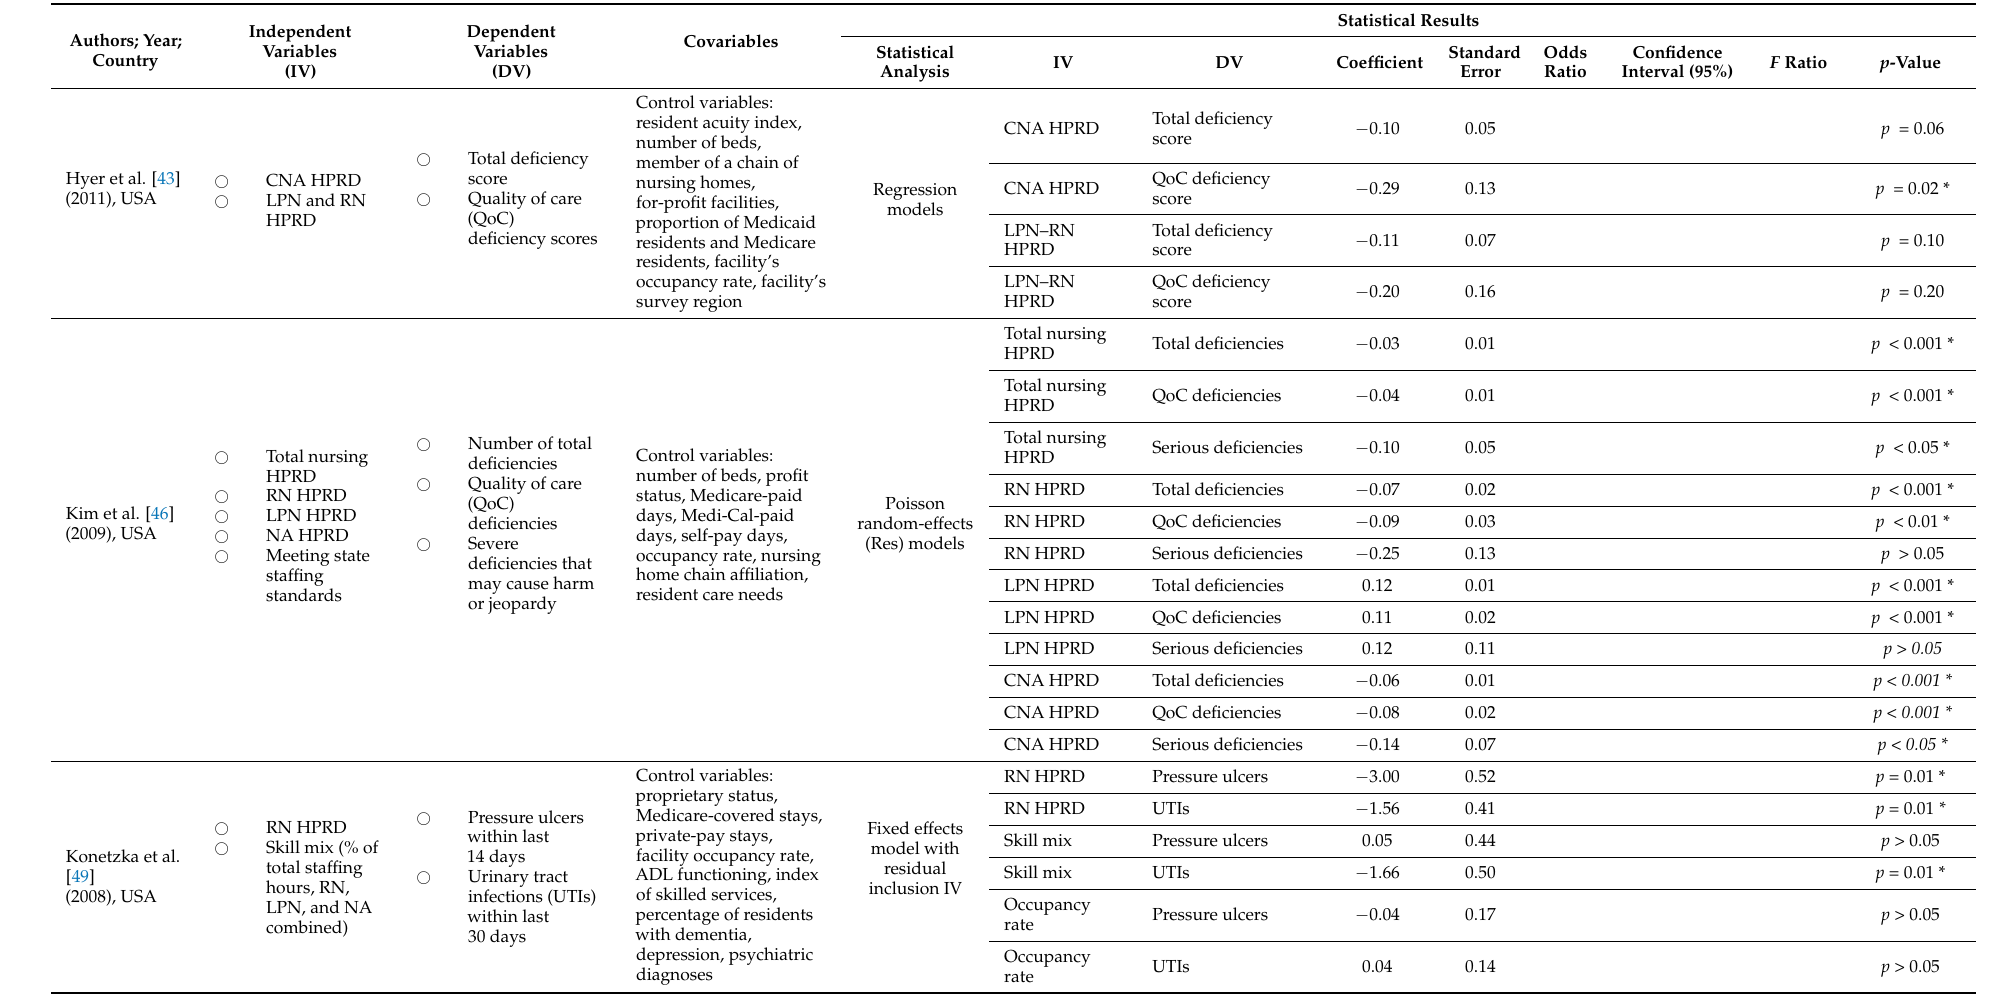
Table 4. Statistical results from the cohort